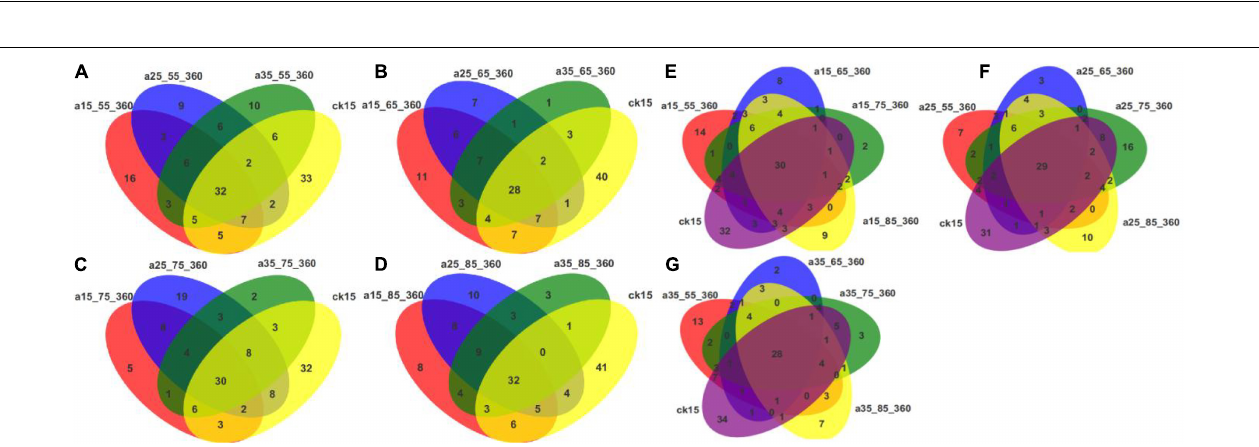
FIGURE 6 | Venn diagrams of OTU distributions in barley under different storage conditions. The Venn diagrams show the common and differential OTU numbers. The different environmental conditions adopt different colors. The numbers within overlapping colors indicate the number of OTUs in common between two or more samples. The numbers within non-overlapping colors represent the number of species that differ. (A–D) Venn diagrams of initial barley and barley stored at 55, 65, 75, and 85% RH. (E–G) Venn diagrams of initial barley and barley stored at 15, 25, and 35 ◦ C.